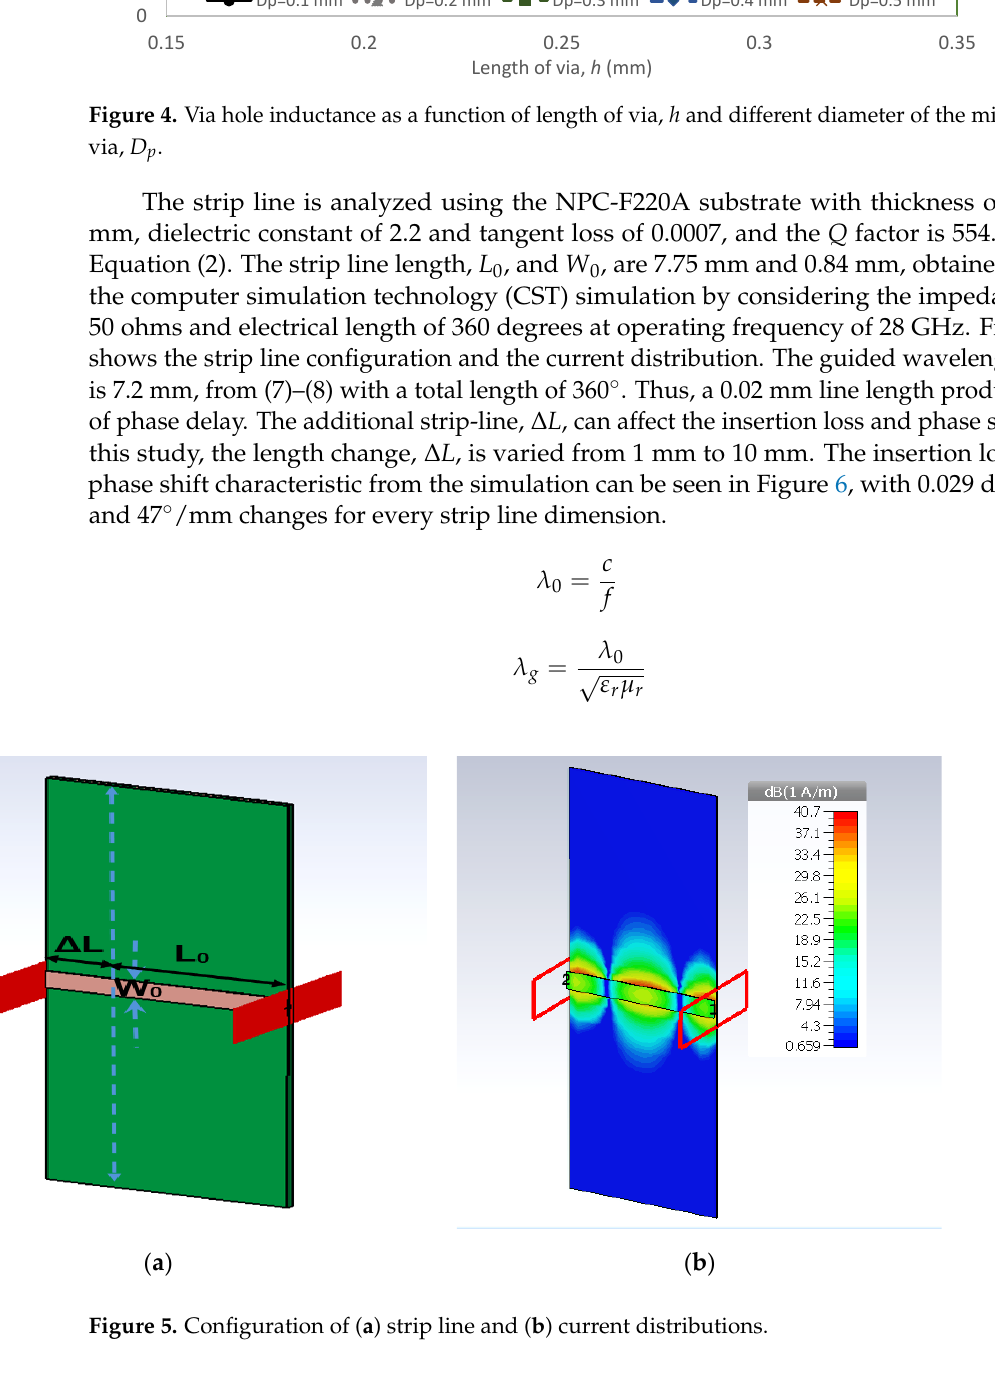
Figure 5. Configuration of ( a ) strip line and ( b ) current distributions.